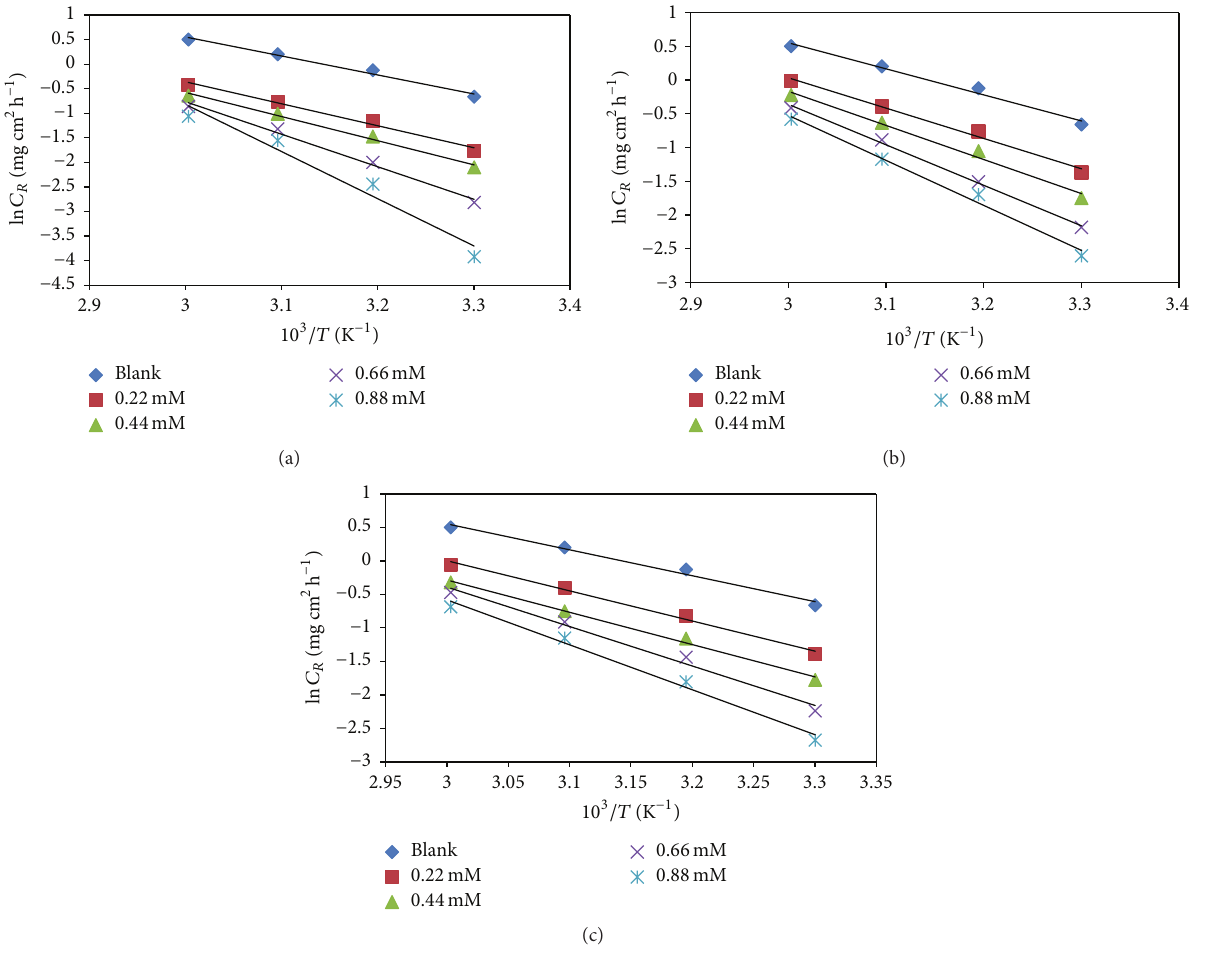
Figure 2: Arrhenius plots in the absence and presence of different concentrations of (a) 2-MTPH, (b) 3-MTPH, and (c) 4-MTPH.